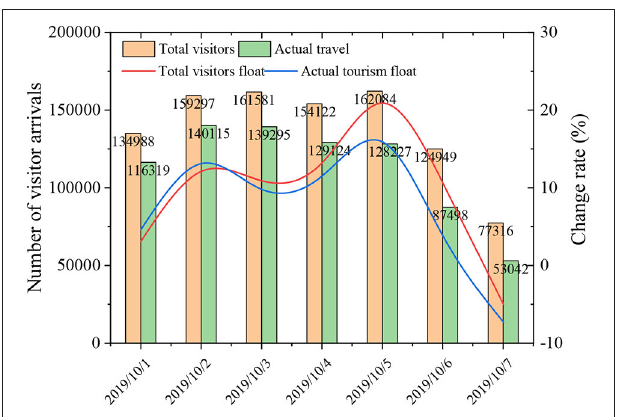
FIGURE 6 | Results of statistical analysis of Macau’s tourism data during the National Day Holidays in 2019.